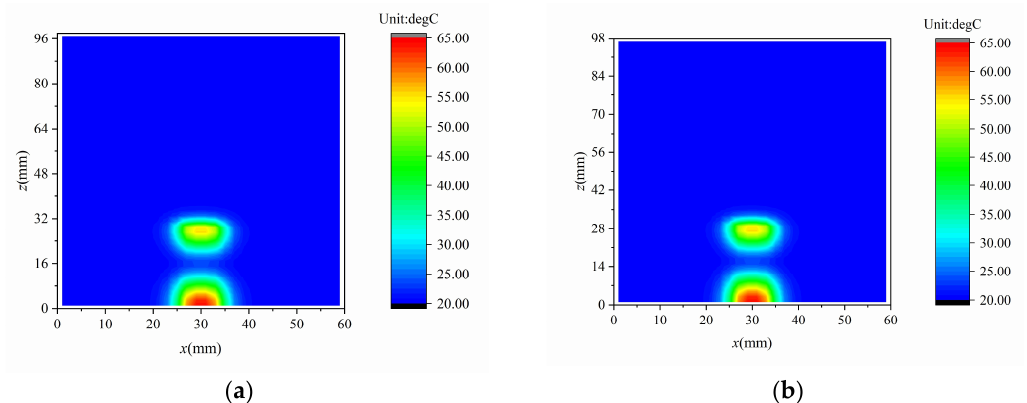
Figure 6. The thermal field distributions on the surface of the dielectric substrate: ( a ) by using traditional FDTD-M; ( b ) by using HIE-FDTD-M.